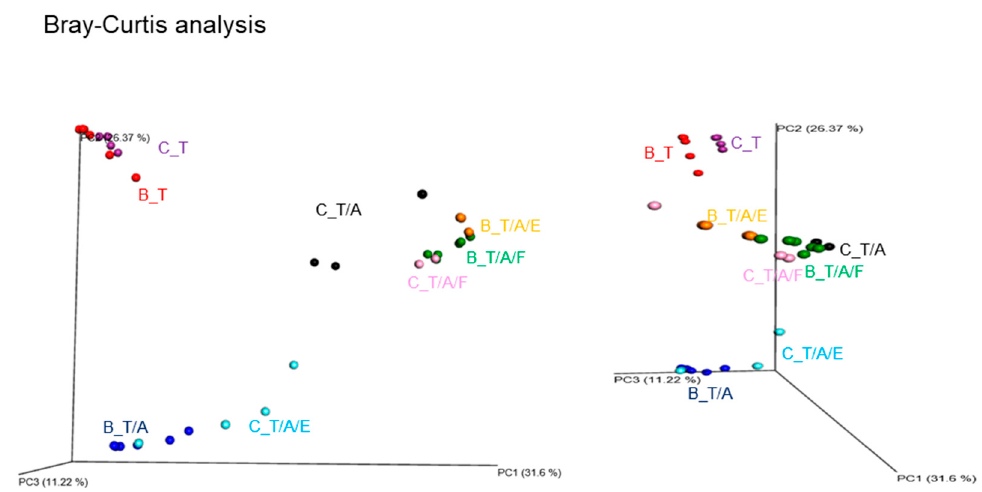
Figure 4. Beta diversity analysis separates samples based on treatment type and mouse strain. Principal coordinate analysis of microbiome samples using Bray–Curtis distance. The microbiome of caecal content obtained from mice on the 8th day after tumour challenge and the indicated treatment was analysed. Each symbol represents each sample. C_T and B_T: BALB/c and B6 mice treated with Tim3VdIg alone, respectively; C_T/A and B_T/A: BALB/c and B6 mice treated with Tim3VdIg and antibiotics; C_T/A/F and B_T/A/F: BALB/c and B6 mice treated with Tim3VdIg, antibiotics, and faecal bacteria; C_T/A/E and B__T/A/E: BALB/c and B6 mice treated with Tim3VdIg, antibiotics, and Enterococcus hirae . p = 0.001 via PERMANOVA, p = 0.013 via permDISP, R = 0.813, p = 0.001 via ANOSIM.